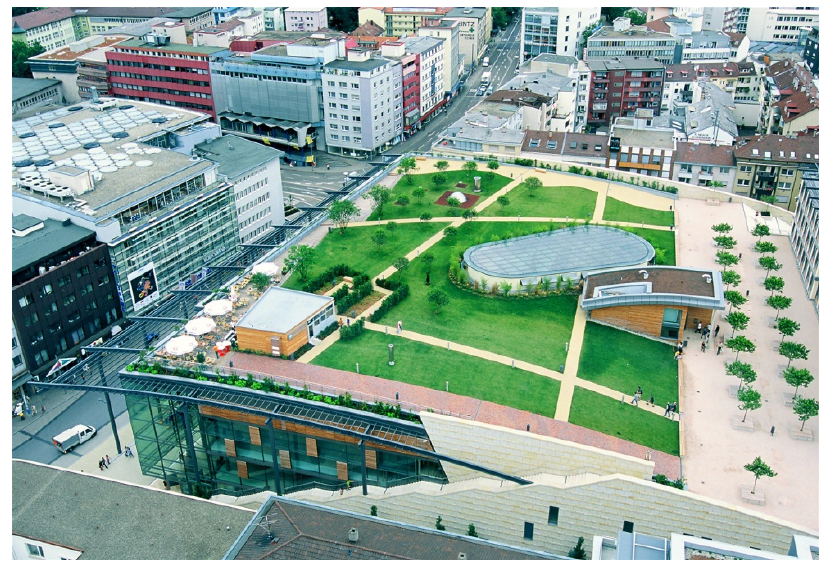
Figure 4. Germany's green roofs. Figure 4. Germany’s green